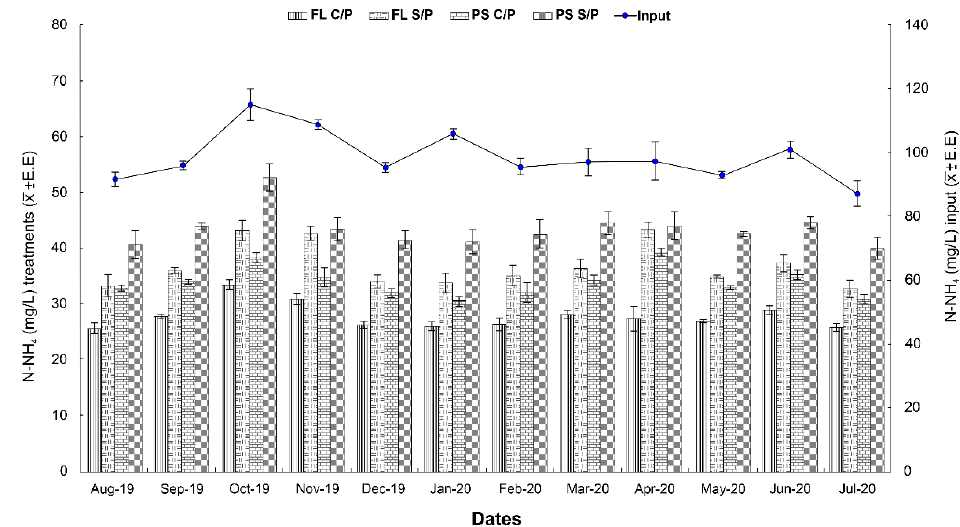
Figure 10. Average N-NH 4 concentrations ( ± E.E.) during the experiment. (FLCP: free flow with plant; FLSP: free flow without plant; PSCP: saturated flow with plant; PSSP: saturated flow with plant; E.E.: standard error).